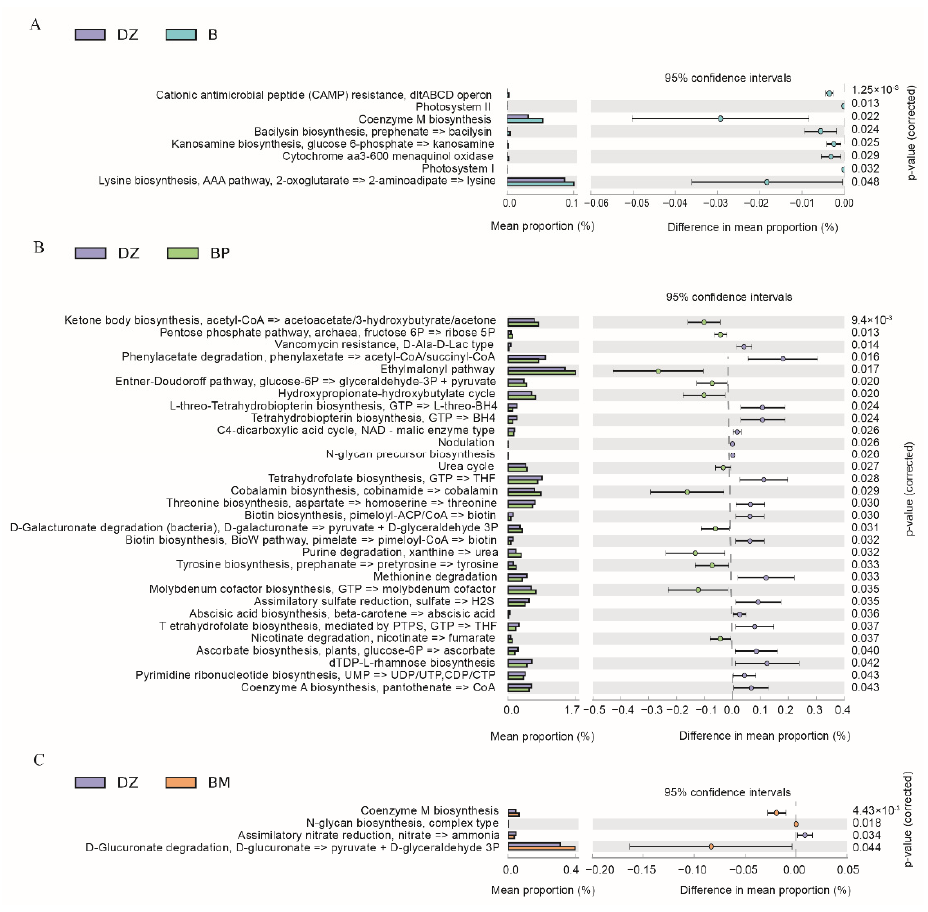
Figure 10. Differences of predicted functions based on the KEGG Module database using STAMP. Note: Only data with significant differences ( p < 0.05) between groups are shown. ( A ) DZ and B group, ( B ) DZ and BP group, ( C ) DZ and BM group. The group B, a single B. pumilus BP-171 was added; the group BP, B. pumilus BP-171, and PHBV were added; the group BM, B. pumilus BP-171, and molasses were added; the group DZ, the control without any probiotics and carbon sources addition.